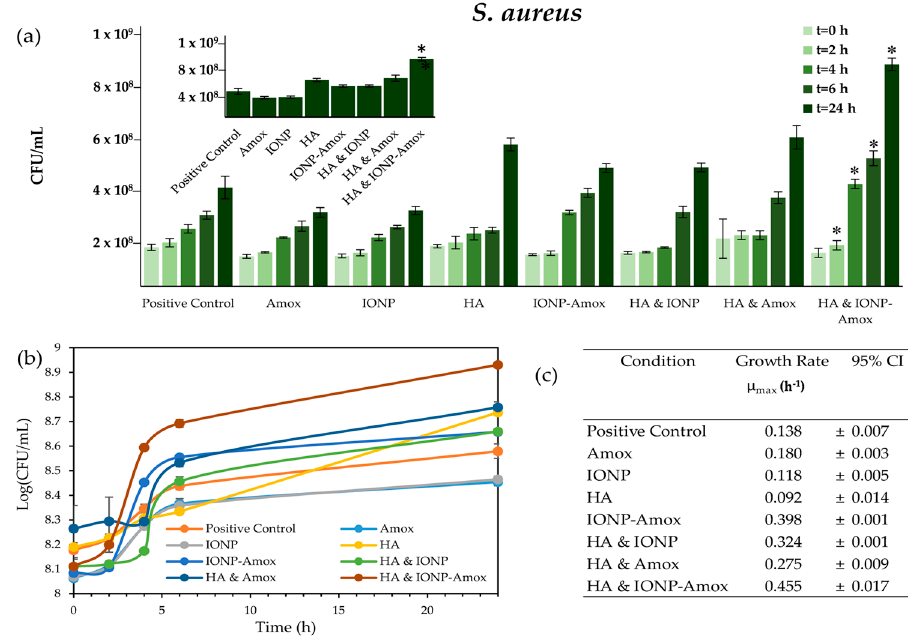
Figure 4. ( a ) S. aureus CFU/mL values for time points 0, 2, 4, 6, & 24 h. Error bars indicate ± SD, asterisk indicates statistical distinction ( α = 0.05) from all other conditions at respective time points. Data indicated by an asterisk statistically differ from all other data within the respective time set; other statistical differences are described in the narrative. Inset graph represents t = 24 h; ( b ) S. aureus growth profiles. Error bars indicate ± SD; ( c ) S. aureus maximum μ max (h − 1 ). 95% Confidence Intervals are indicated.